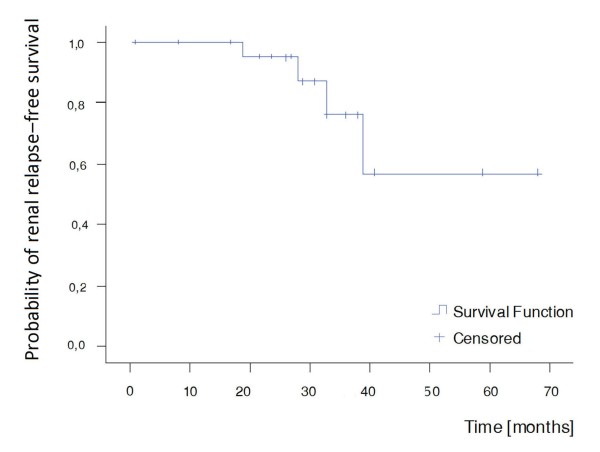
Kaplan-Meier curve for renal relapse. No median survival time.